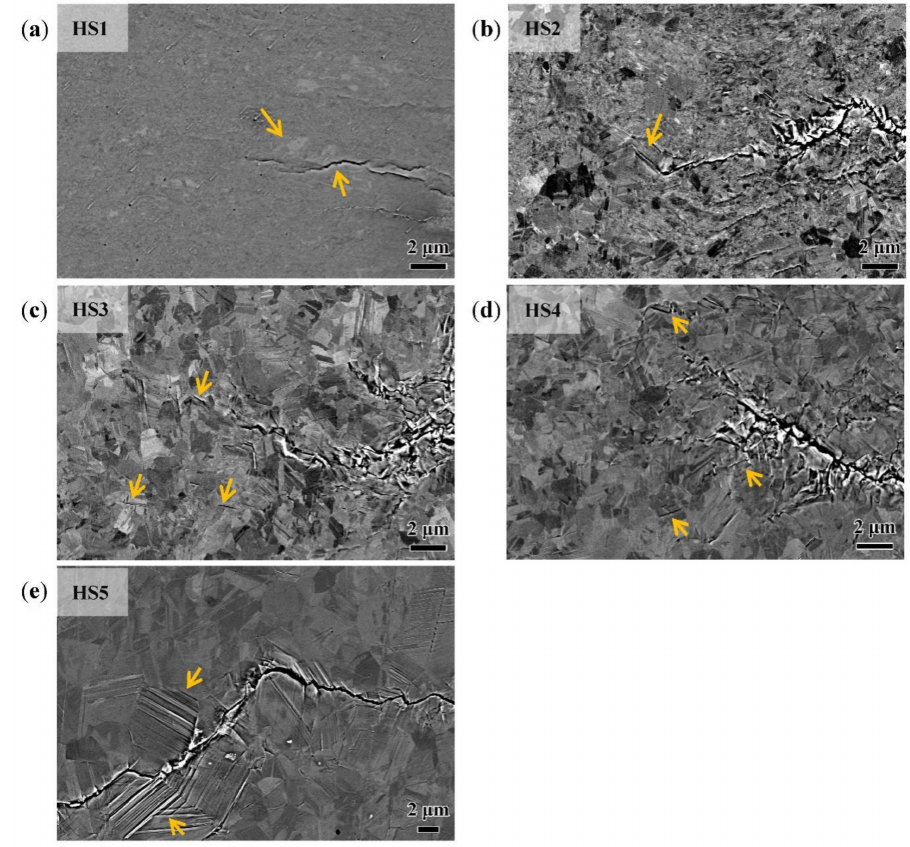
Figure 5. BSE images of the fatigue crack growing paths on the different heterostructured specimens. ( a ) HS1, fatigue crack bypassed RG when the crack tip met it (indicated by arrows). ( b ) HS2, fatigue crack grew alone the slip plane of the RG when the crack tip met it (indicated by arrow). ( c ) HS3, ( d ) HS4, and ( e ) HS5. Isolated microcracks appeared along the twin boundaries (indicated by arrows in ( c – e